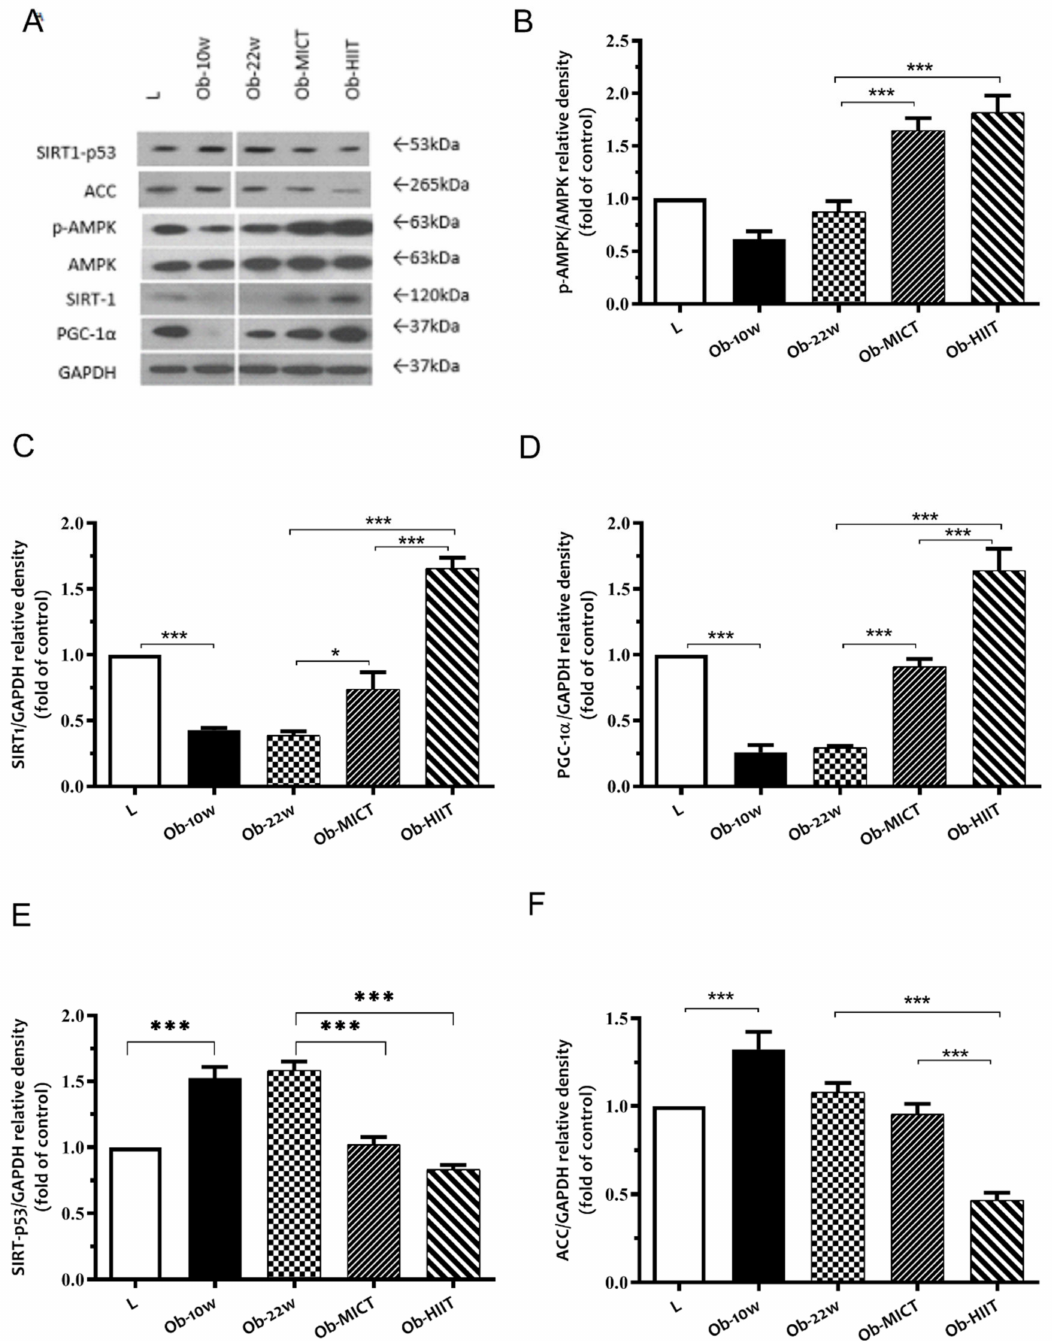
Figure 4. The e ff ect of obesity and exercise training on protein expression of adipocyte di ff erentiation markers in subcutaneous adipose tissue. ( A ) Western blot analysis of protein expression of p-AMPK, AMPK, SIRT1, PGC-1 α , and GAPDH. Quantification graphs of ( B ) p-AMPK, ( C ) SIRT1, ( D ) PGC-1 α , ( E ) SIRT1-p53, and ( F ) ACC proteins relative to GAPDH. Data are represented as means ± SEM ( n = 6) and significant di ff erence between groups indicated by * p < 0.05, *** p < 0.001. L: lean; Ob-10w: obesity-10 weeks; Ob-22w: obesity + sedentary; Ob-MICT: obesity + moderate-intensity continuous training; Ob-HIIT: obesity + high-intensity interval training